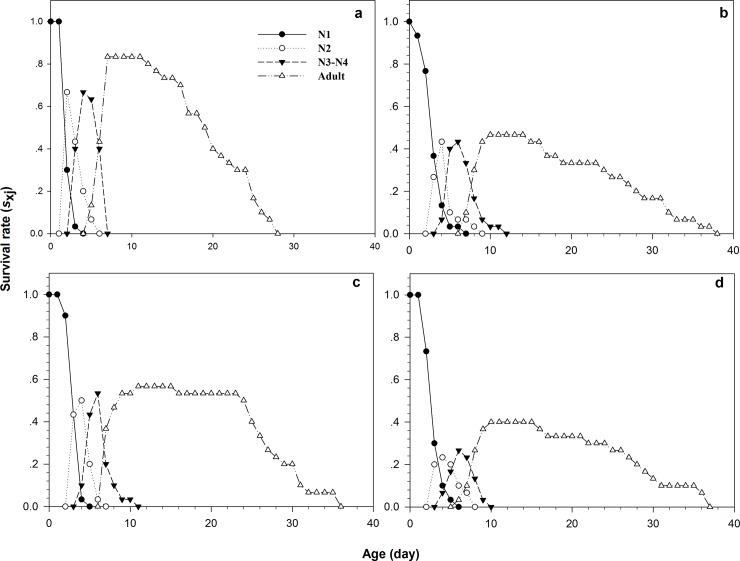
Age-stage-specific survival rates (sxj) of Rhopalosiphum padi, the parental females of which were exposed to wheat leaves treated with different concentrations of imidacloprid.(a) Control, (b) LC10, (c) LC20, (d) LC25.